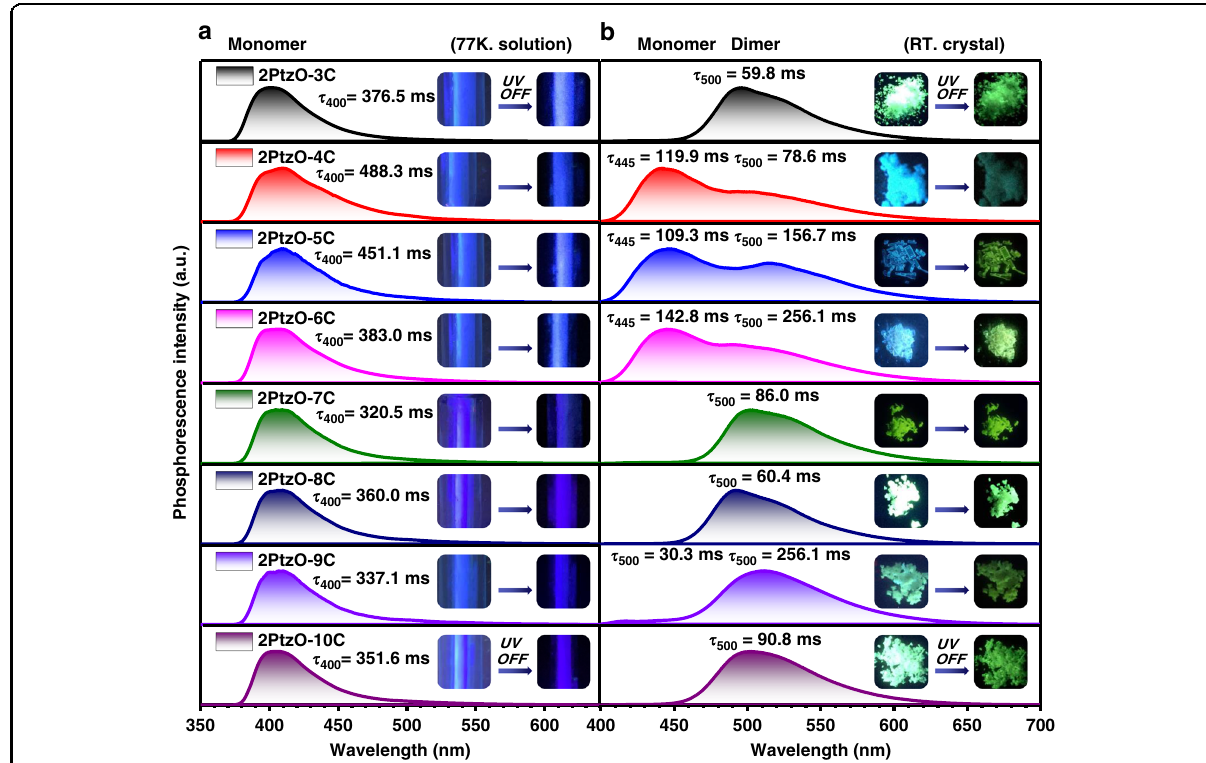
Fig. 2 Phosphorescence property of 2PtzO-nC in different states. a The phosphorescence spectra of eight compounds ( 2PtzO-nC ) in dilute DCM solution (10 µM; λ ex = 330 nm) at 77 K and b in crystal state at room temperature ( λ ex = 365 nm). Insert graph: photographs of 2PtzO-nC in corresponding states before and after the removal of UV